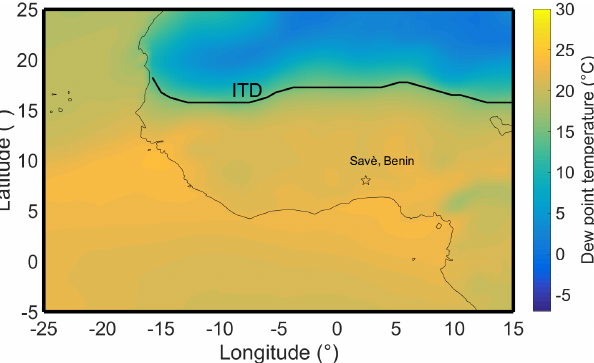
Figure 1. Mean dew point temperature obtained from the ECMWF reanalysis at 2m over southern West Africa during June 2016 and (solid black line) mean intertropical discontinuity (ITD) position during that month. The ITD position is deduced from the dew point temperature isoline of 15 ◦ C. The star indicates the location of the Savè